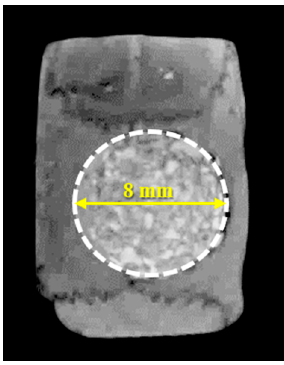
Figure 2. Area of interest (AOI) for volumetric analysis.